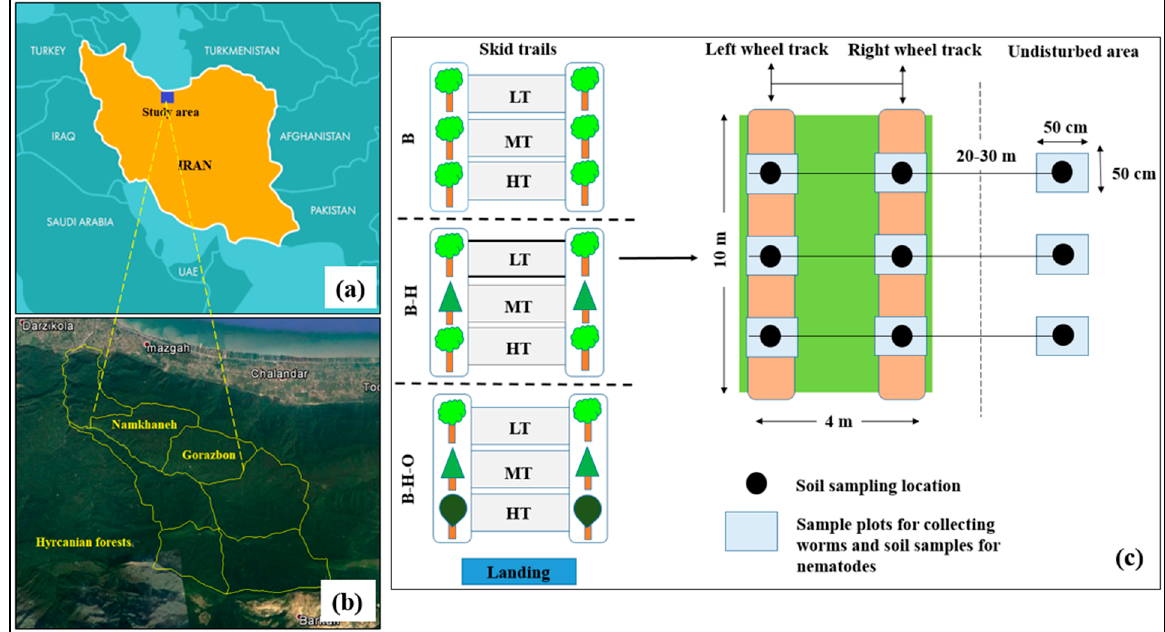
Figure 1. Location of the study area in northern Iran ( a ); Kheyrud forests (Namkhaneh and Gorazbon districts) within the Hyrcanian forests ( b ); schematic representation of the experimental design on the skid trail and undisturbed area ( c ). Different tree litter treatments: B: beech, B-H: beech–hornbeam, B-H-O: mixed beech or beech–hornbeam–other species. Different traffic intensities: HT: high traffic intensity, MT: medium traffic intensity, and LT: low traffic intensity.